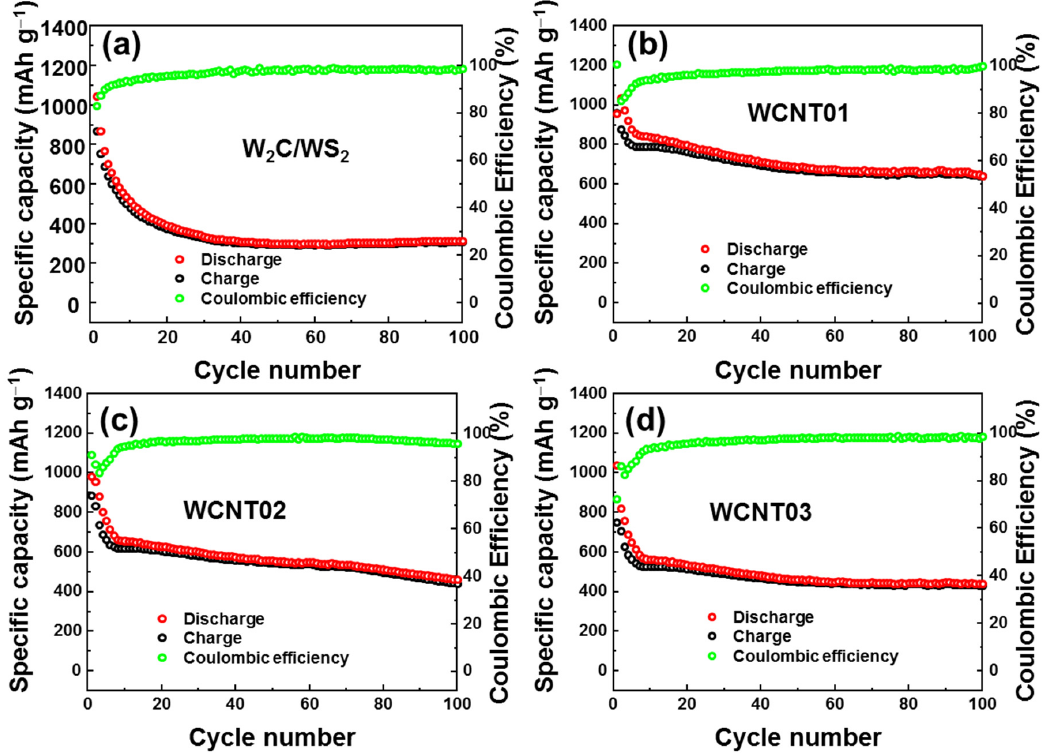
Figure 6. Cyclic performance of the ( a ) W 2 C / WS 2 alloys, ( b ) WCNT01, ( c ) WCNT02, and ( d ) WCNT03 anodes under the current rate of 0.1 A g − 1 .